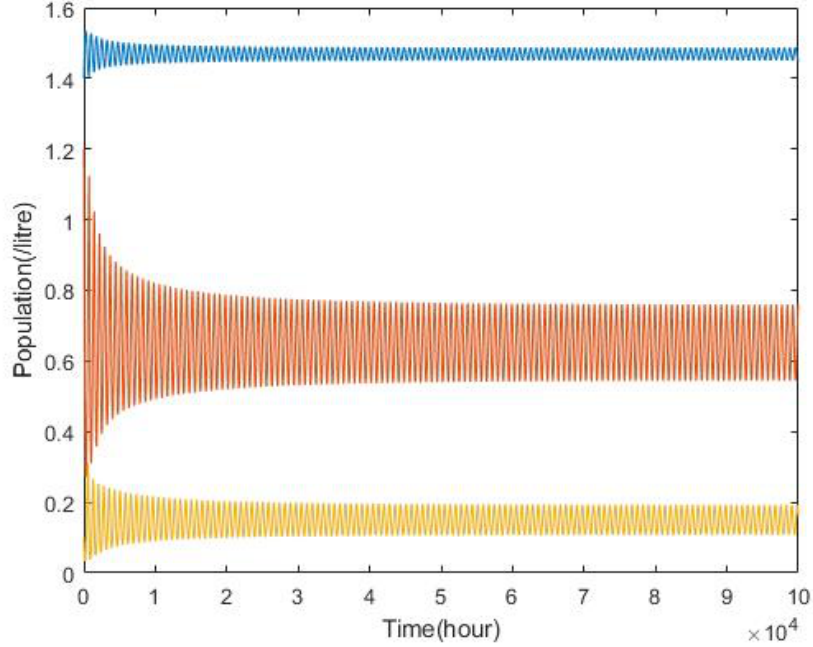
Figure 17. Simulation results of System (16) for τ = τ +